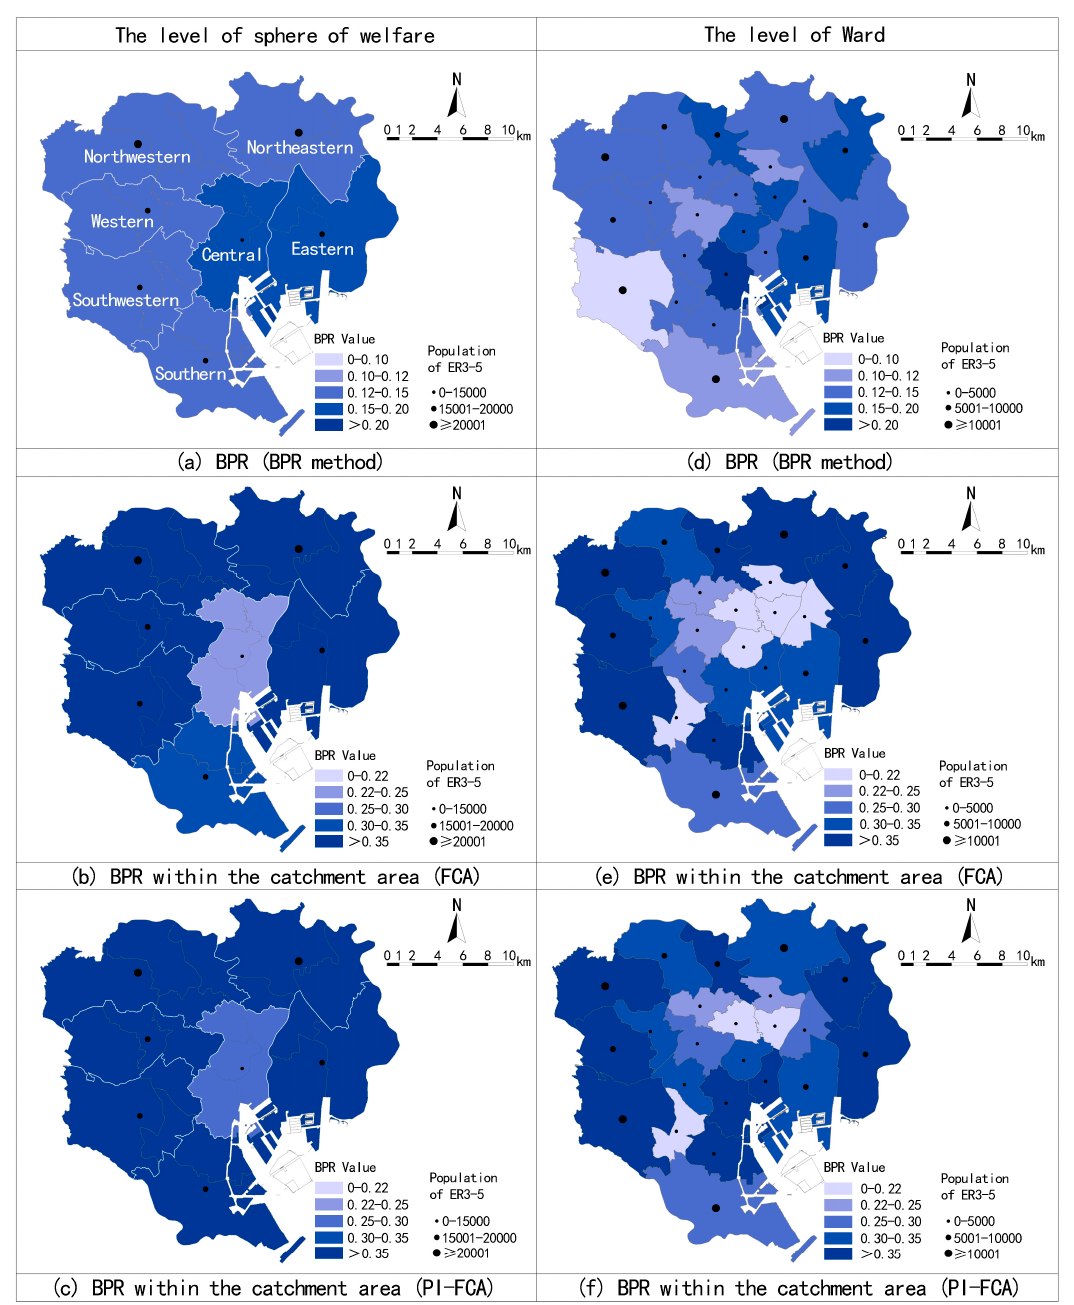
Figure 4. Estimates by the beds-to-elderly population ratio (BPR) method, floating catchment area method (FCA), and parameter-improved floating catchment area method (PI-FCA) at sphere of welfare ( a – c ), and ward ( d – f ).